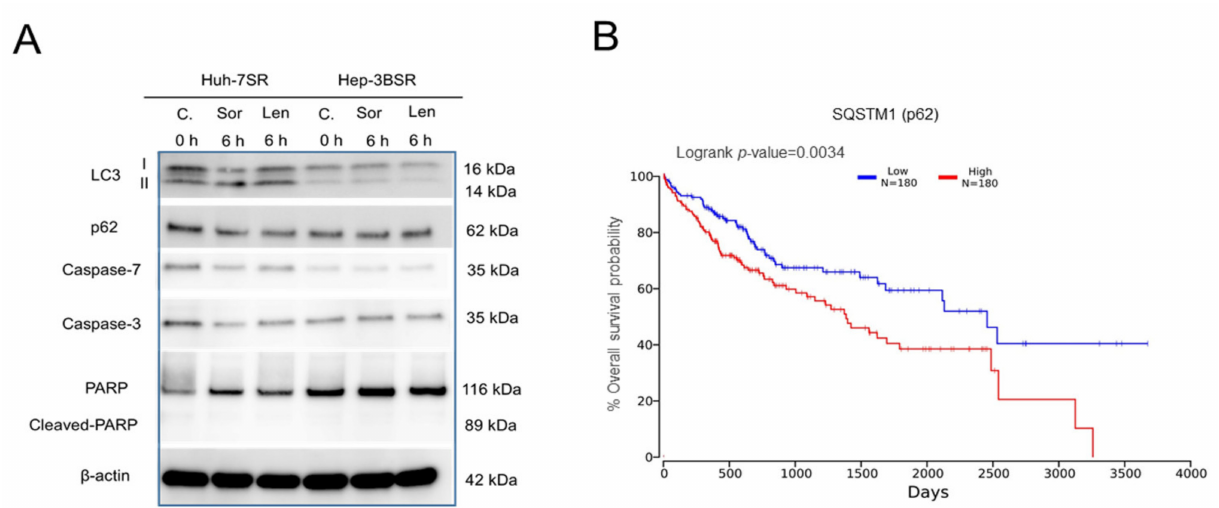
Figure 5. Autophagic response of sorafenib-resistant cells to sorafenib or lenvatinib. ( A ) Huh-7SR and Hep-3BSR cells were treated with 10 µ M sorafenib or lenvatinib for 6 h. LC3, p62, caspase-7, caspase-3, and PARP expression were analyzed using Western blot. C.: control; Sor: sorafenib; Len: lenvatinib. ( B ) A lower p62 level is associated with longer overall survival of HCC patients based on TCGA database analysis (http://www.oncolnc.org, accessed on 5 October